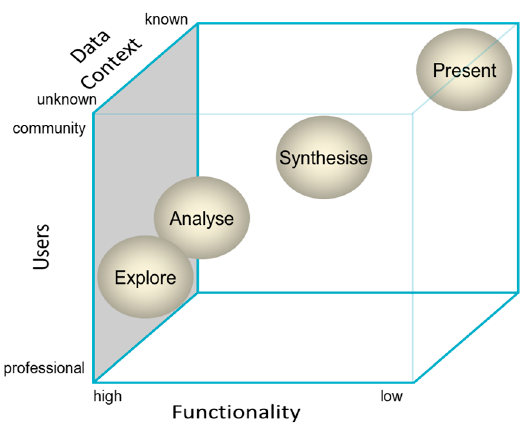
Figure 5. Component dimensions influencing web map use ([100]; Adapted from [99]).